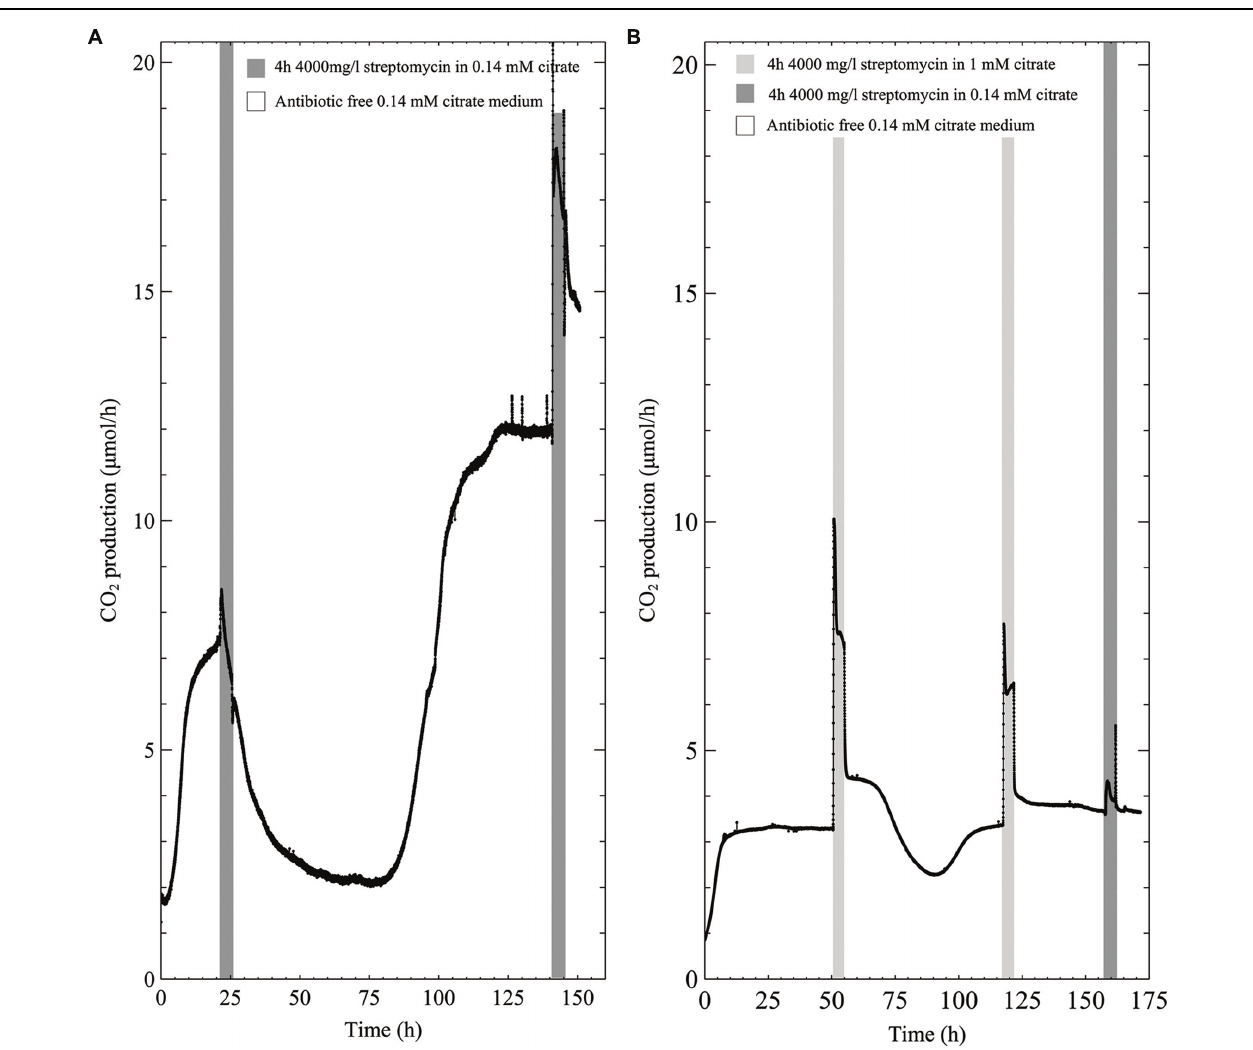
FIGURE 3 | CO 2 production ( µ mol/h) of multispecies biofilms grown in 0.14 mM citrate defined medium and exposed to 4000 mg/l streptomycin for 4-h intervals; (A) 0.14 mM citrate medium (B) 0.14 mM citrate growth medium with the addition of 1 mM citrate during the first and second exposure, and a third antibiotic exposure in 0.14 mM citrate